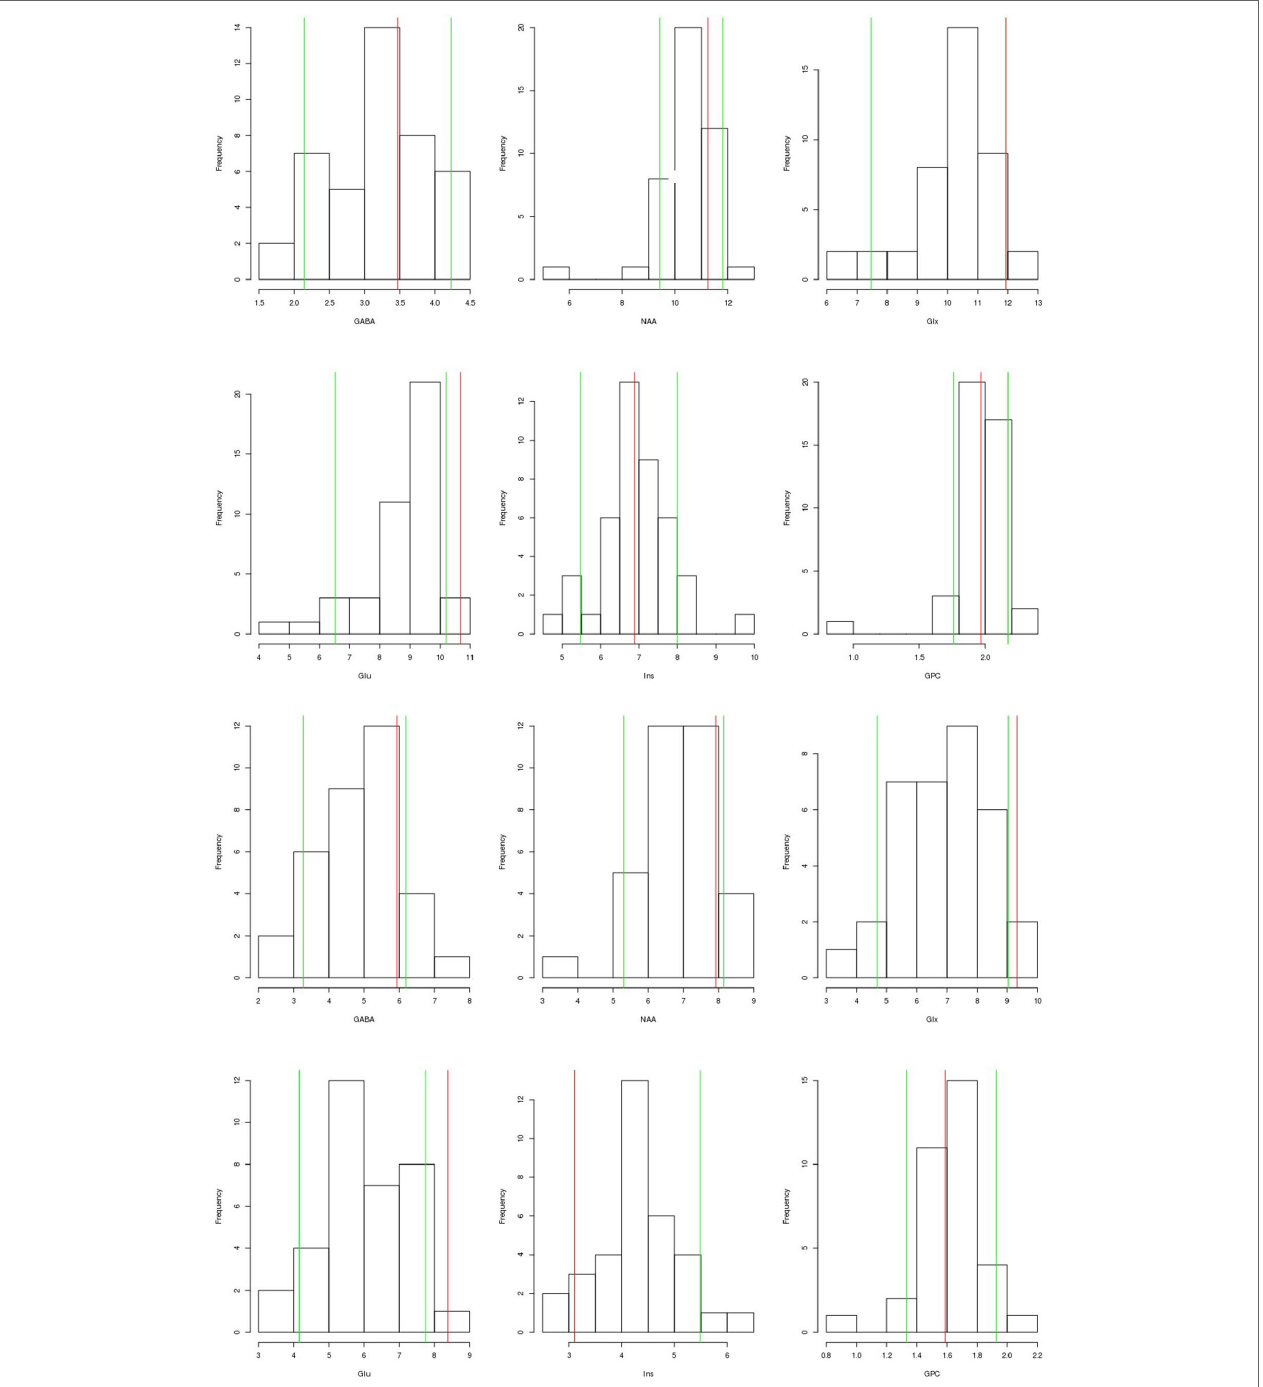
FIGURE 2 | Magnetic resonance spectroscopy (MRS) findings: We present the findings of the dorsal anterior cingulate cortex (dACC; the two upper rows) and the pregenual anterior cingulate cortex (pACC; lower rows). The patient’s values (red line) are compared to the values of a healthy control group measured in another study (N = 43, mean age: 35, gender ratio: 14 females/29 males). The green line shows the 90% reference interval of the control group. For Glx in the dACC and Ins in the pACC the green (90% reference interval) and the red line (patient’s values) are superimposed, therefore only the red line is visible. The measured metabolite concentrations have been corrected for MRS voxel composition (content of gray matter, white matter, and cerebrospinal fluid), as well as for the influence of age and differences in the signal-to-noise ratio of the MRS measurements. Abbreviations: GABA, gamma-aminobutyric acid including coedited macromolecules; NAA, N-acetylaspartate; Glx, glutamate and glutamine; Glu, glutamate; Ins, myo-inositol; GPC,